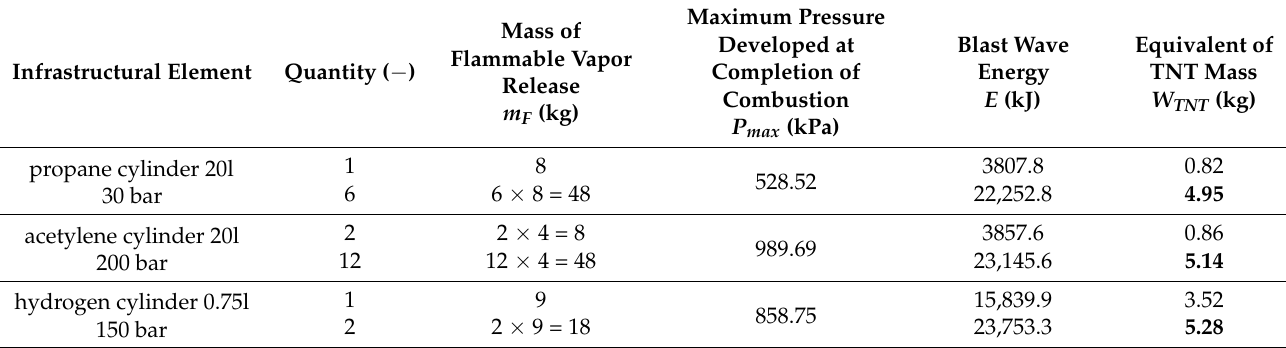
Table 1. Selected industrial infrastructural elements, which are outside the building, and estimated basic data concerning their unconfined vapor cloud explosion (UVCE).